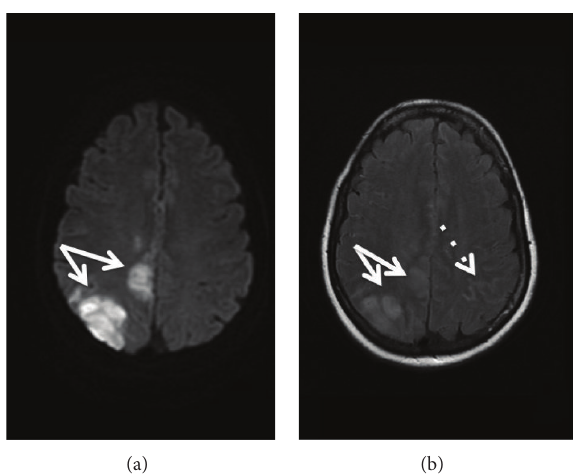
Figure 1: Diffusion-weighted imaging (a) and fluid-attenuated inversion recovery imaging (b) MRI of the patient, showing cytotoxic oedema in the right middle cerebral artery and anterior cerebral artery territories (plain arrows) and cSAH (discontinued